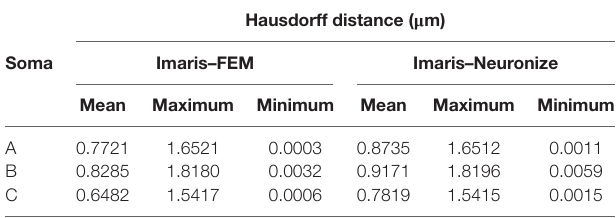
tABLe 2 | Hausdorff distance (mean, maximum, and minimum) between the real somata, obtained with Imaris, and the generated somata, using Neuronize and the FEM-based method.